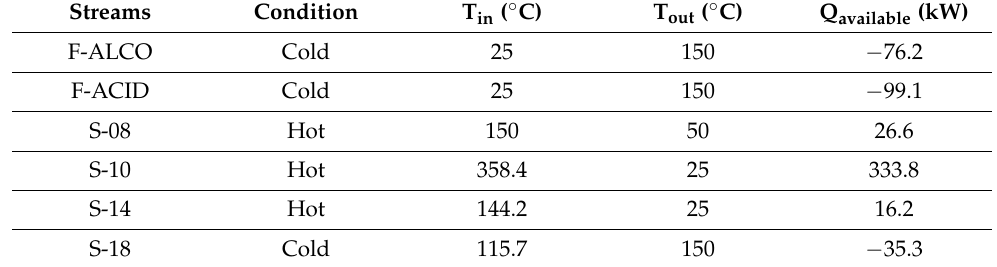
Table 4. Stream conditions of the process flowsheet reported in Figure 2 used for heat integration.